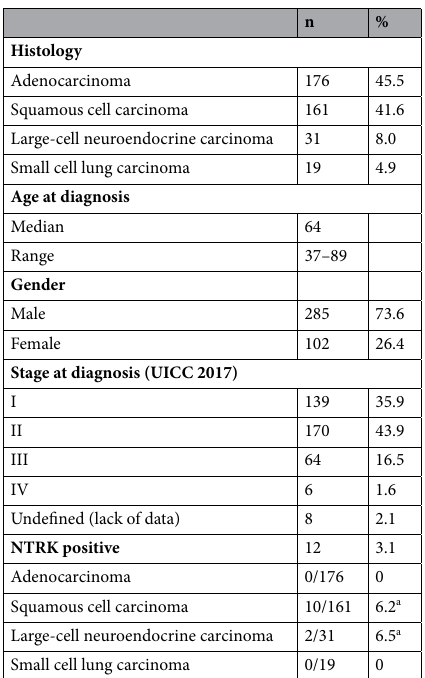
Table 1. Study cohort with the results of immunohistochemistry with a pan-TRK antibody. a % of the number of each histologic subtype, not of the whole study